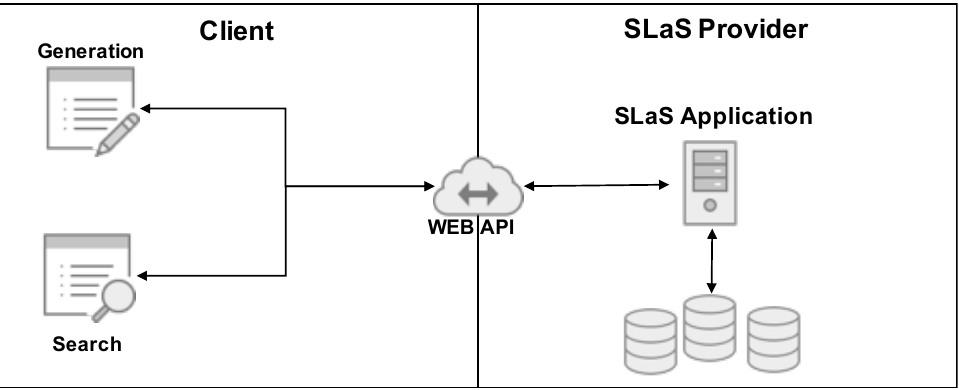
Figure 1. Reference